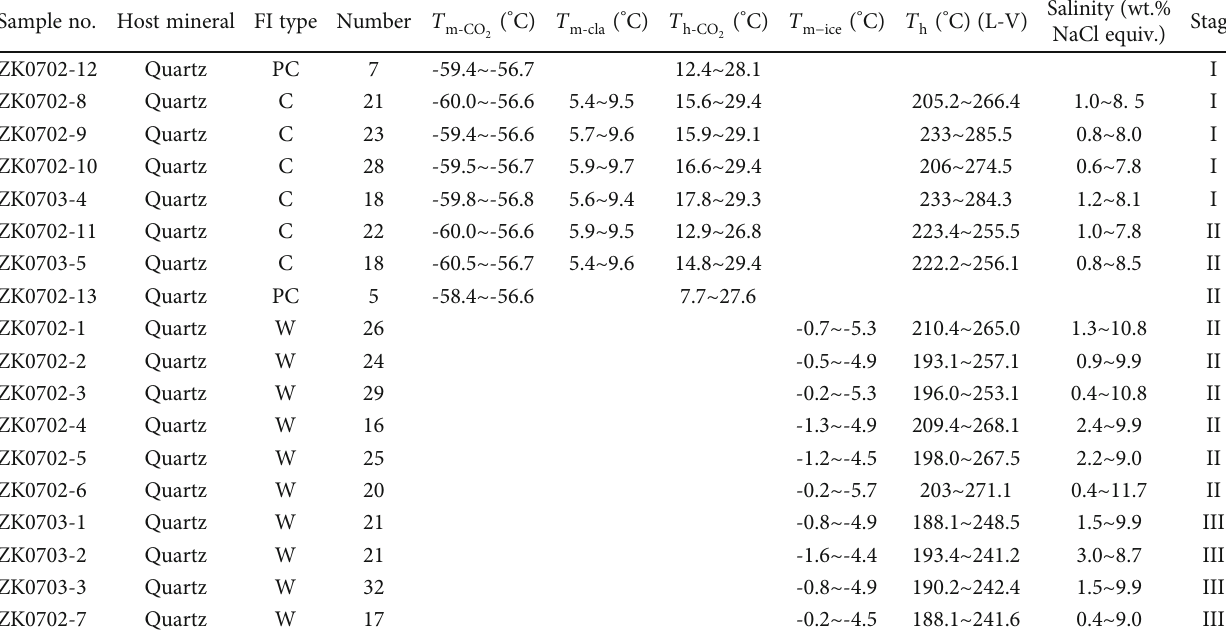
Table 1: Microthermometric data for fl uid inclusions of di ff erent stages from the Yuka gold deposit. Table 1 is reproduced from Chai et al. [77], (under the Creative Commons Attribution License/public